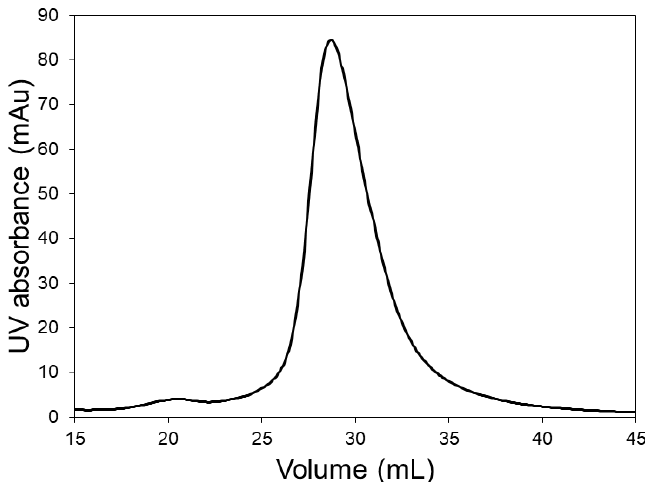
Figure 3. Chromatogram of dimer containing lysozyme sample obtained with the LFMC device (membrane: Sartorius S; membrane bed volume: 4.7 mL; feed: 0.5 mg/mL lysozyme; sample volume: 2 mL; binding buffer: 20 mM sodium phosphate pH 6.0; eluting buffer: binding buffer + 0.5 M NaCl; linear gradient volume: 20 mL; flow rate: 15 mL/min).